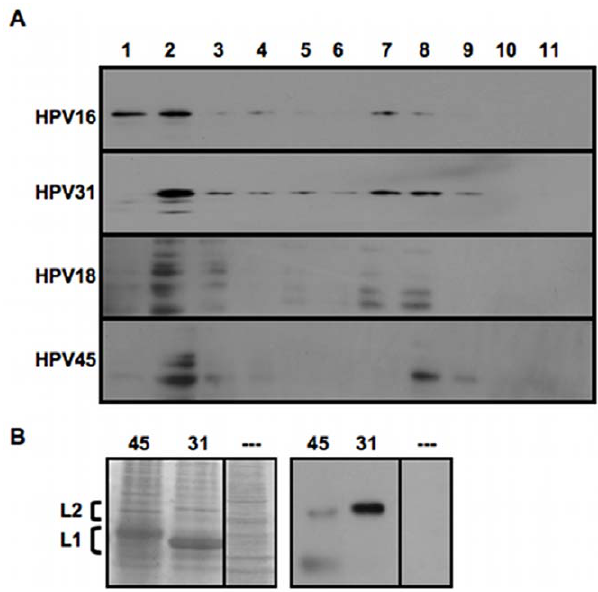
Figure 4. Western blot analysis of Opriprep-purified L1 + L2 VLPs. (A) HPV16, HPV31, HPV18, and HPV45 VLPs were Optiprep- fractionated and fractions were assayed for L2 content by probing Western blots with anti-HPV16 L2 polyclonal antibody anti-P56/75 # 1. (B) Side-by-side SDS-PAGE gels run with equivalent amounts of HPV45 and HPV31 L1 + L2 VLPs from Optiprep fraction # 8 were either Coomassie-stained, or Western blotted with anti-P56/75 # 1. L2 and L1 bands are indicated by brackets (note the small size difference in L2 and the larger size difference in L1). A control lane that represents an SDS-PAGE gel of Optiprep-purified 293TT cell lysate without capsid protein was also included for the Coomassie stained samples (—). doi:10.1371/journal.pone.0016405.g004 PLoS ONE |